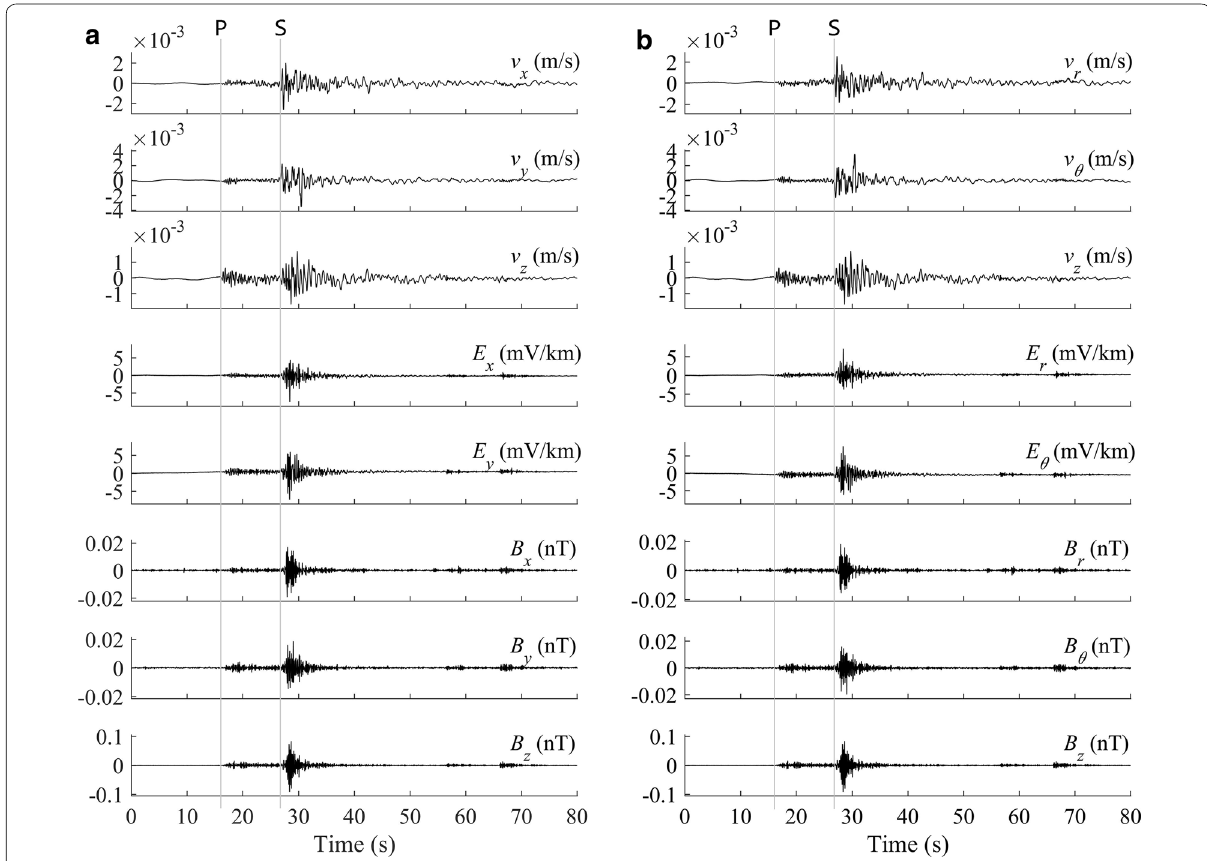
Fig. 2 Seismic and EM recordings of an aftershock. This is a M 5.4 aftershock occurring at 01:44 (in JST) on April 16, 2016, that is, 19 min after the mainshock of M 7.3 Kumamoto earthquake. The recordings are displayed in a Cartesian and b cylindrical coordinates, respectively. The seismic and EM time series in this figure are displayed at 32 Hz sampling rate. Thus, the frequency band of the recordings is 0–16